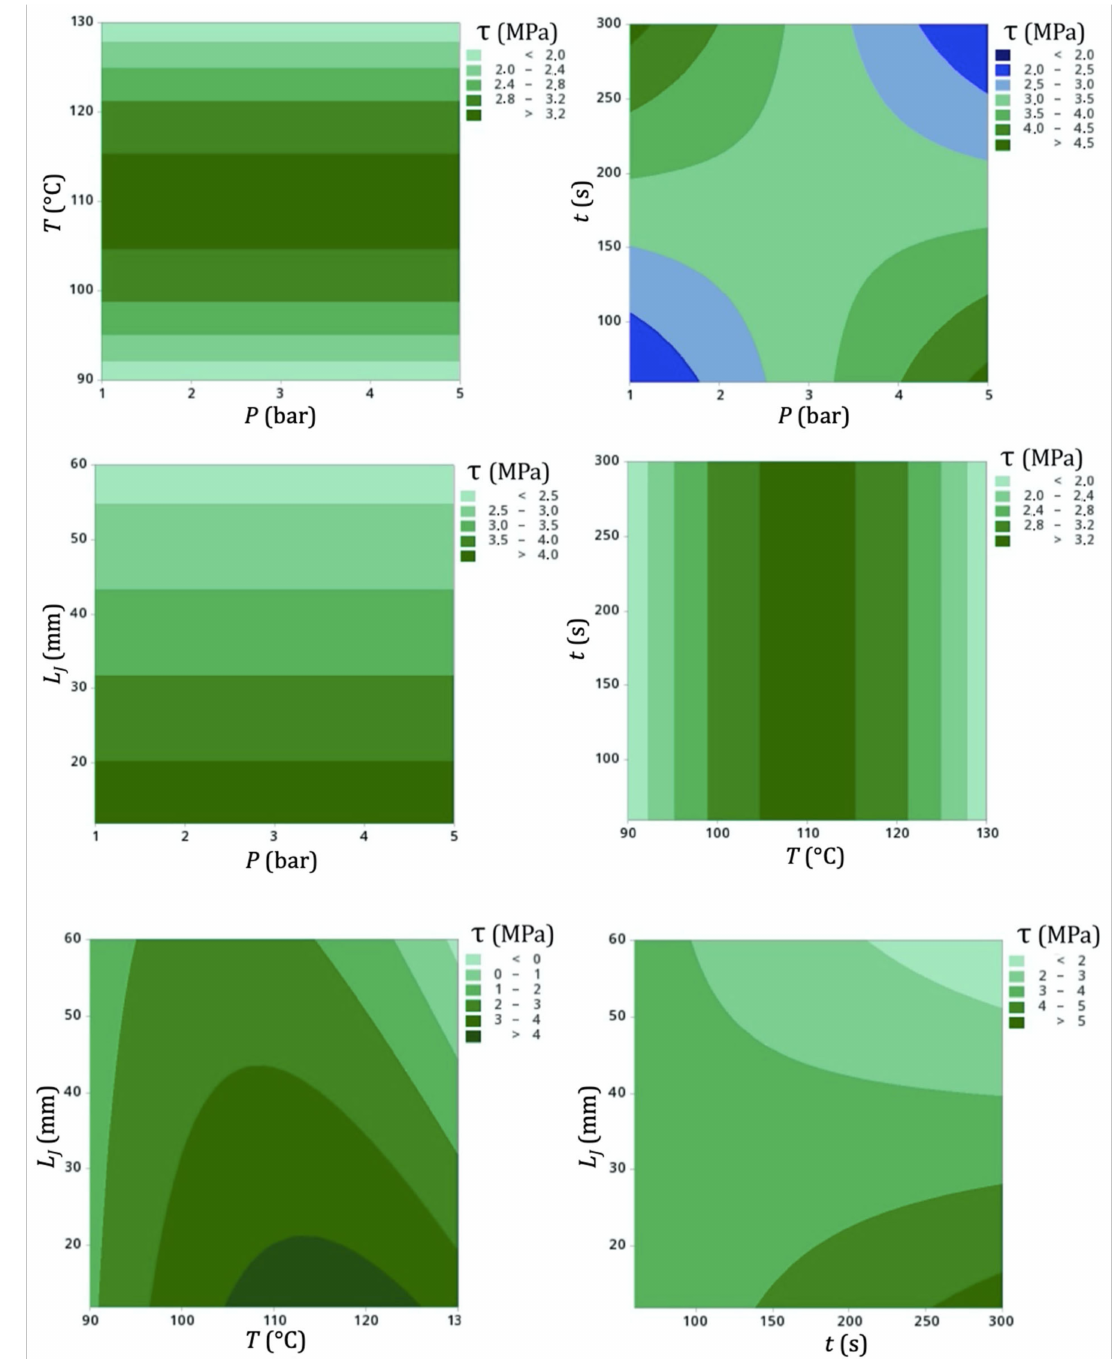
Figure 11. Contour plots of shear stress as a function of cure process